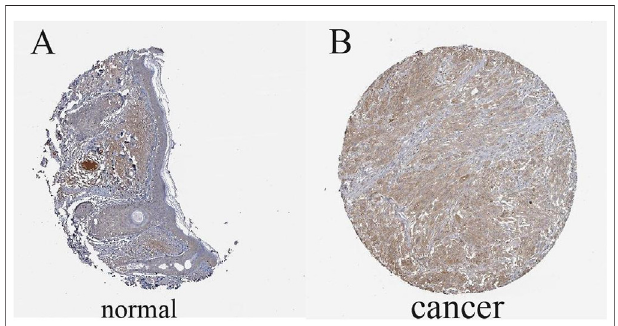
FIGURE 9 | T-SNE describes the expression pro fi le of FAT10 in a single cell obtained from SKCM tissue. Each dot represents a cell (A) . The CancerSEA database determines the correlation between FAT10 expression and two functional states (B) . ** p < 0.01.